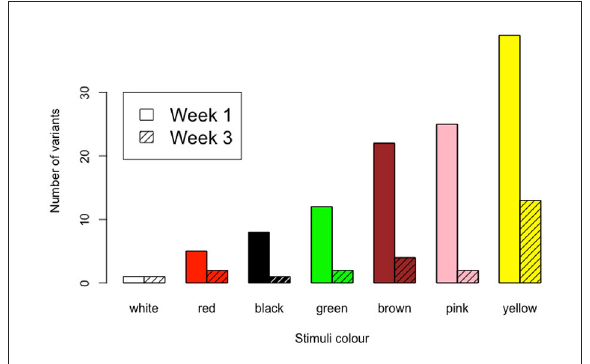
FIGURE10 Number of variants used in the first week (left column of each pair) and the final week (right column of each pair,